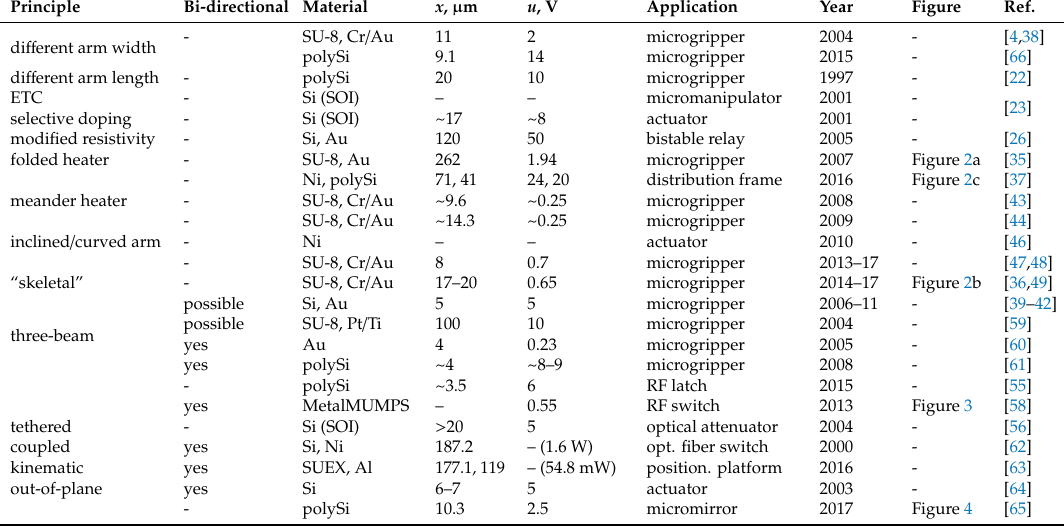
Table 1. Summary of hot-and-cold-arm actuators and applications ( x —maximum displacement demonstrated, u —corresponding driving voltage).